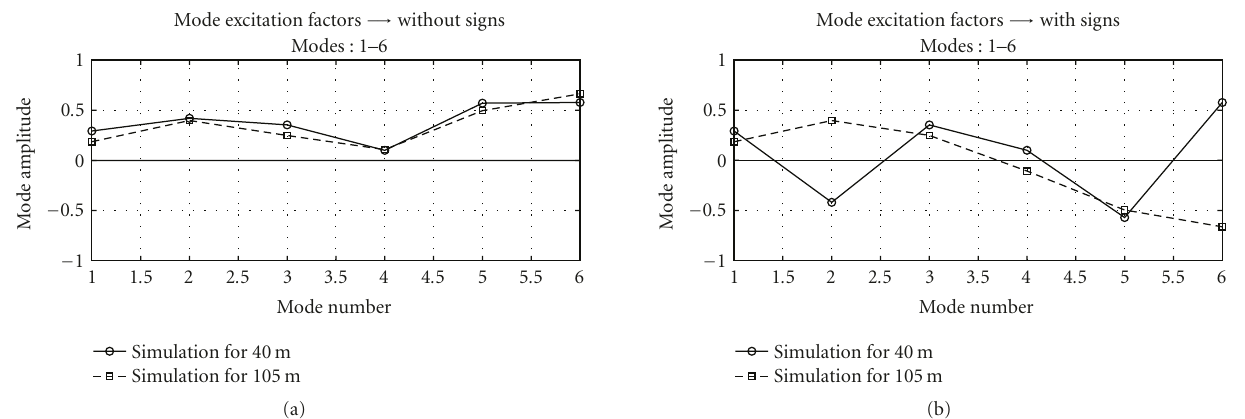
Figure 18: Mode excitation factors extracted from 2 simulations: source at 40m and 105 m of depth. (a) represents the mode excitation factor modulus (no sign information) and (b) shows the mode excitation factor modulus combined with sign information.